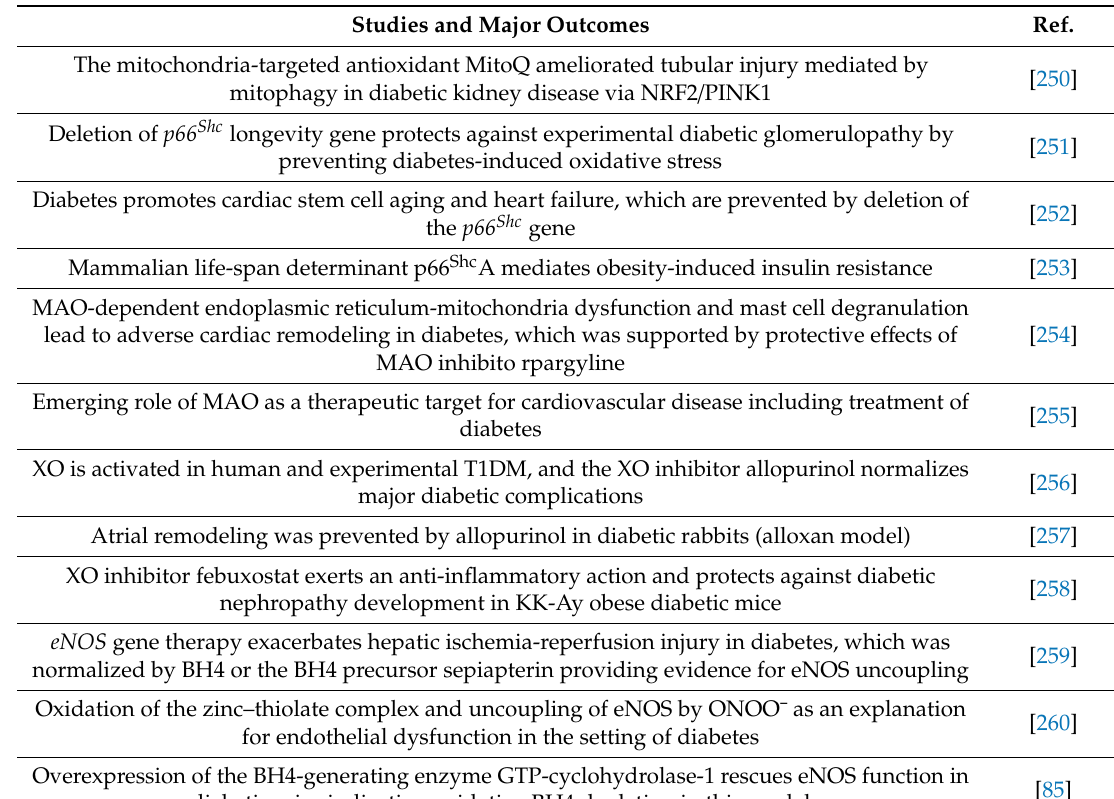
Studies and Major